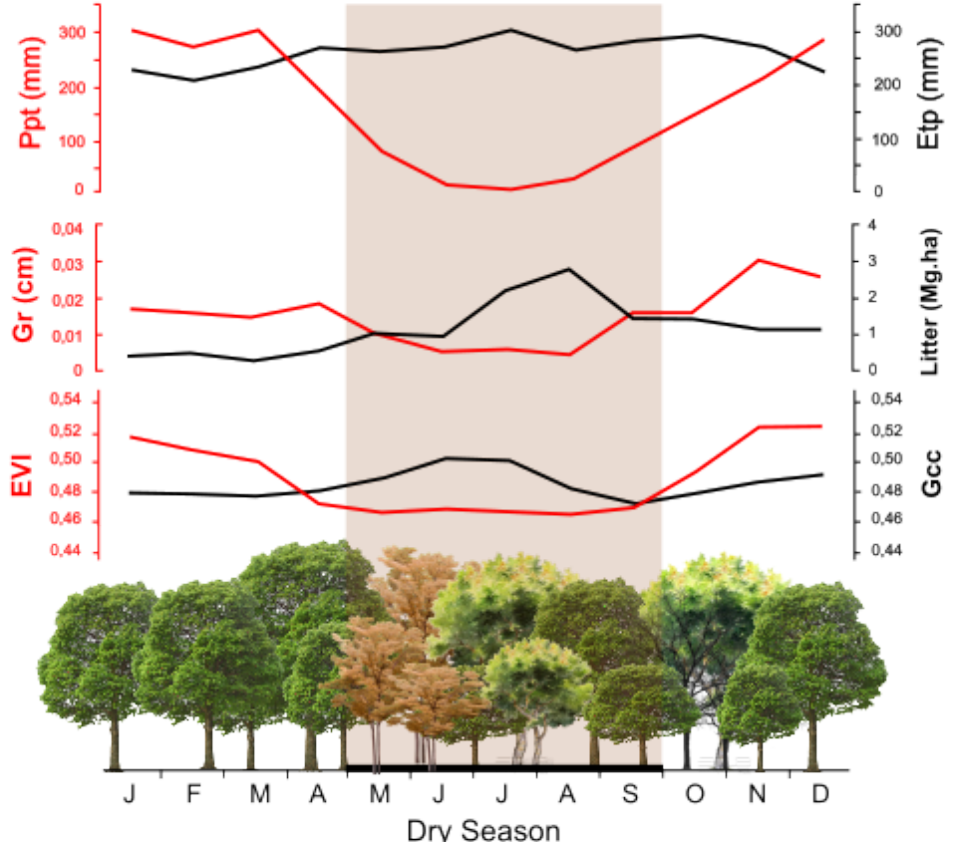
Figure 8. Seasonal pattern based on the historical average of the variables. Ppt = precipitation (NOAA 1983/2015); Etp = evapotranspiration (MOD16A2 2001/17); Gr = stem growth (RJA 2015/17); Total Litter (RJA 2016/18); EVI (MODIS/MAIAC 2000/17); Gcc (MODIS/MAIAC 2000/17). Total litter increased in the dry season and decreased in the wet season (Figure 8), which corroborates the seasonality of the EVI, showing an increase in the wet season and decrease in the dry season with 3 months lag ( R 2 = 0.64, p -value < 0.001), when new leaves are expected to reach maturity 3–5 months after being produced [72,73], thus increasing the photosynthetic activity of the